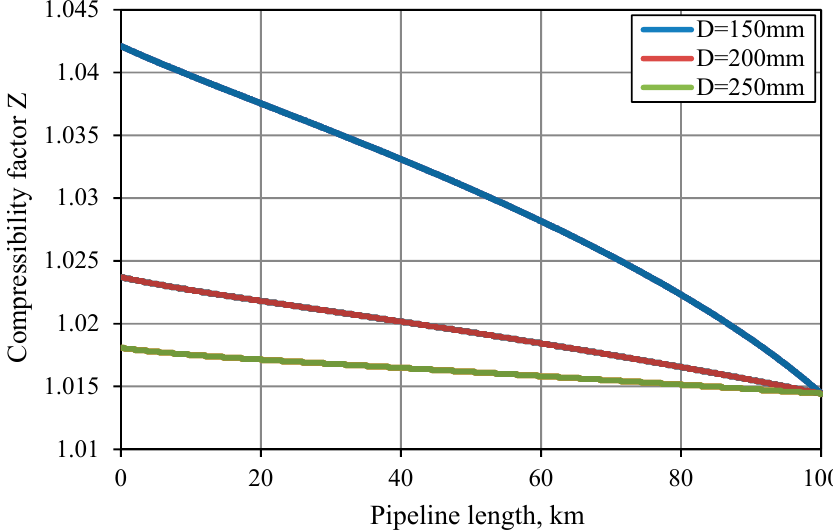
Figure 11. Compressibility factor changes for hydrogen mass flow rate 1.0 kg/s (40,000 Nm 3 /h).